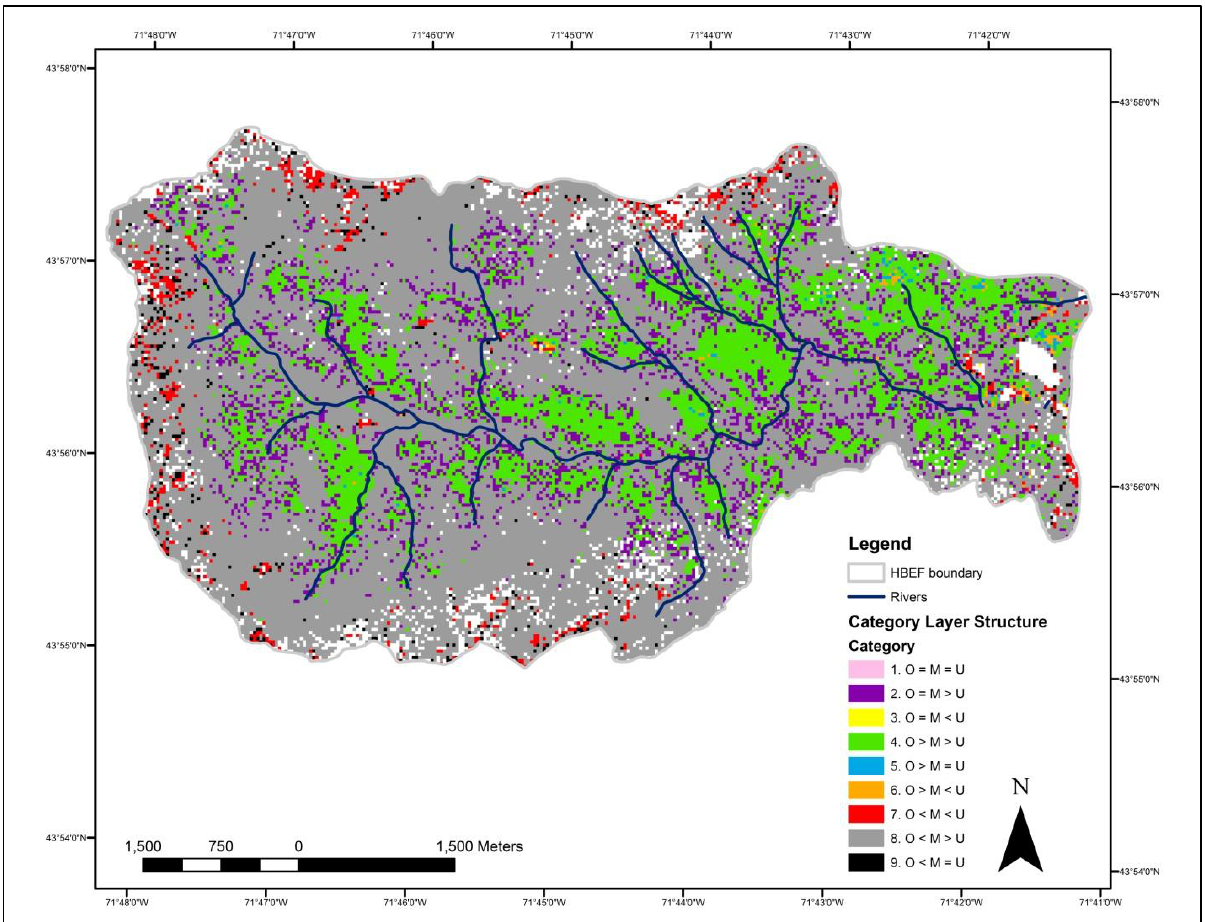
Figure 6. Map of canopy layer structure categories in Hubbard Brook. Categories 2 and 4 were mainly found in the forest interior, along rivers. Categories 7 and 9 were predominantly along the ridgeline. Category 8 was found throughout the study